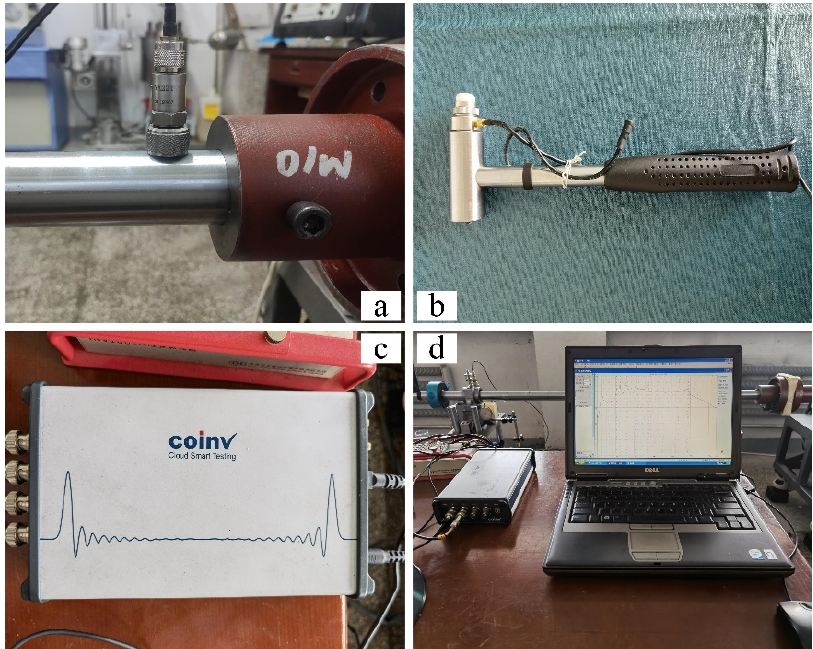
Figure 3. ( a ) Uniaxial acceleration sensor YA-22T; ( b ) Impact hammer YC-1160401; ( c ) Data acquisition system INV-3062T; ( d ) PC.